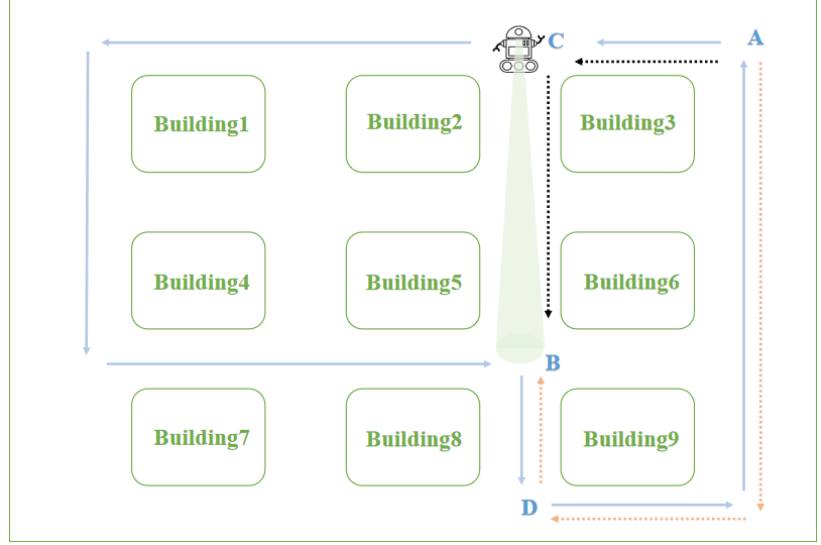
Figure 2. Schematic diagram of a robot system using a connectivity network.